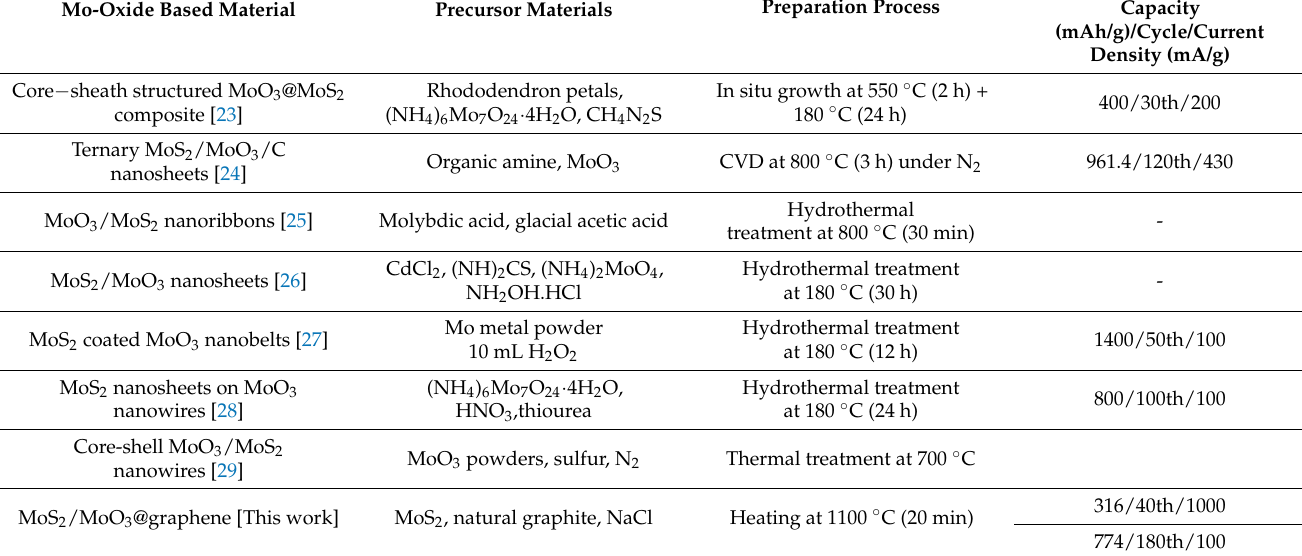
Table 5. A comparison between selected MoO 3 /MoS 2 materials extracted from the literature, and MoO 3 /MoS 2 @G-1100 prepared here, in terms of the precursor materials, preparation method, and the electrochemical